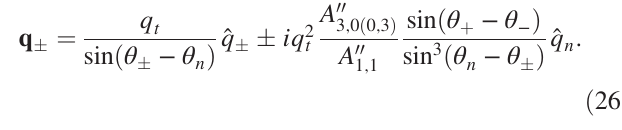
FIG. 6. Shape of the edge modes in a system with polarization Δ N ¼ 2 . We impose a mode with wavelength λ ¼ 15 . 6 j l boundary ˆ r (where l 1 is the first lattice primitive vector). This t mode then propagates through the bulk and decays along the direction ˆ r . Each mode (red or blue) varies sinusoidally along its n corresponding soft direction; therefore, it also varies along the boundary with a longer wavelength. The modes decay into the bulk over length scales much longer than this